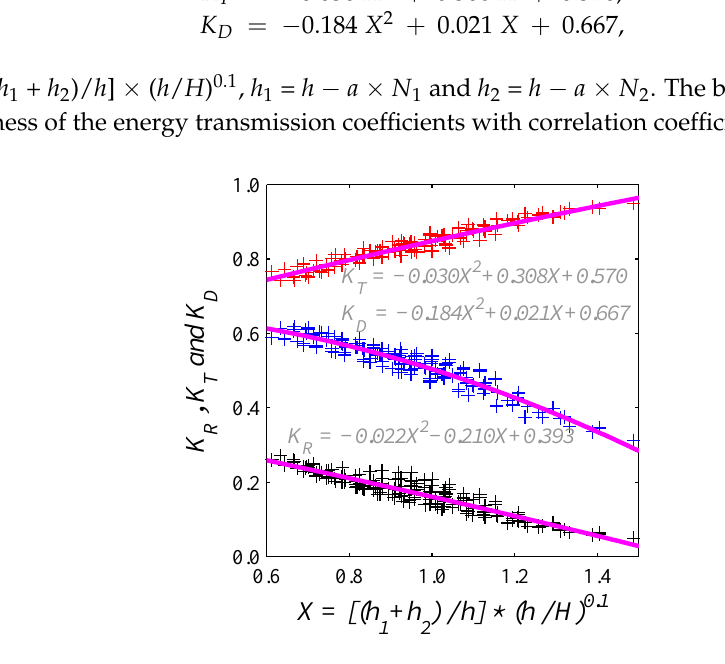
Figure 12. Regression analyses based on all simulations in terms of the hydraulic performance ( h 1 = h – a × N 1 , h 2 = h – a × N 2 ). Symbols in black, red and blue colors represent K R , K T and K D , respectively, where the purple lines indicate the associated fitting curves for each energy coefficient.